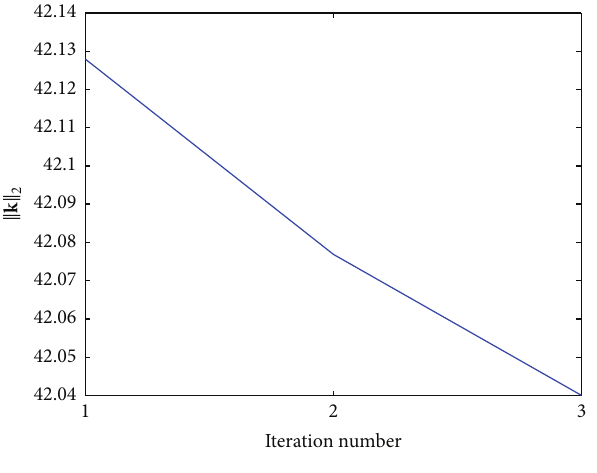
Figure 3: Iterative process of Example 2.